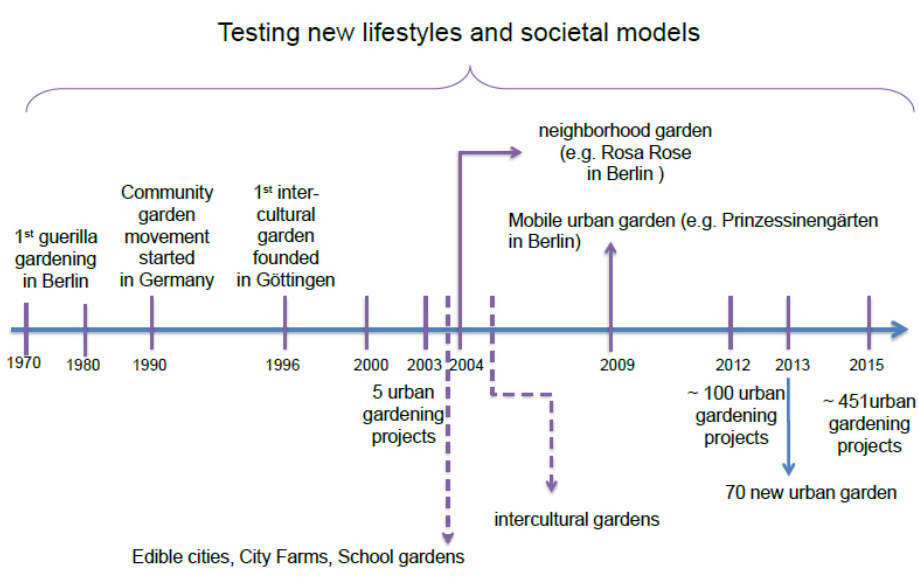
Figure 4. Testing new lifestyles and societal models—A timeline of urban gardens’